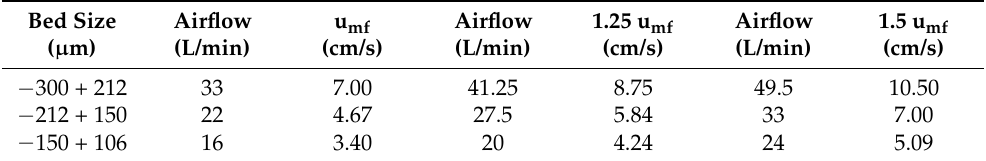
Figure 1. ADAC Forte positron camera with the fluidized bed placed between the detectors. Table 1. Airflow rates for different